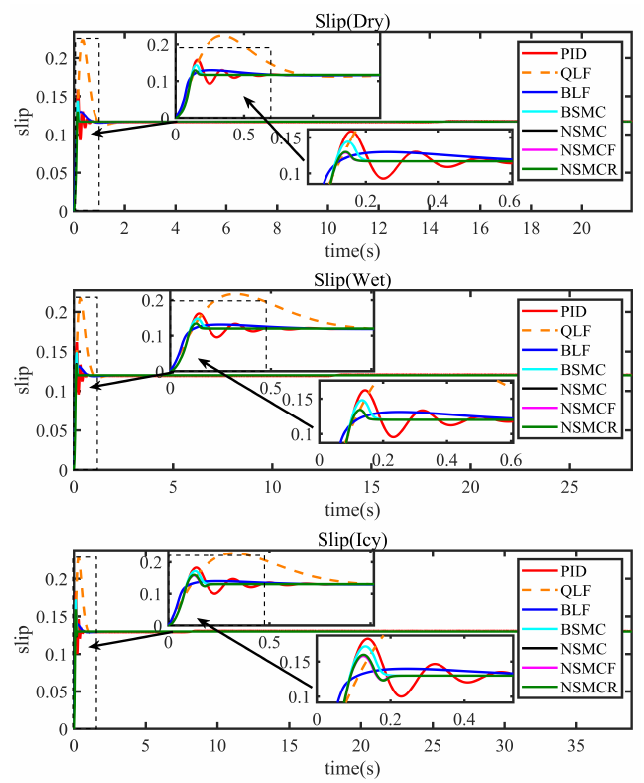
Figure 7. Simulation results of main wheel slip rate tracking.